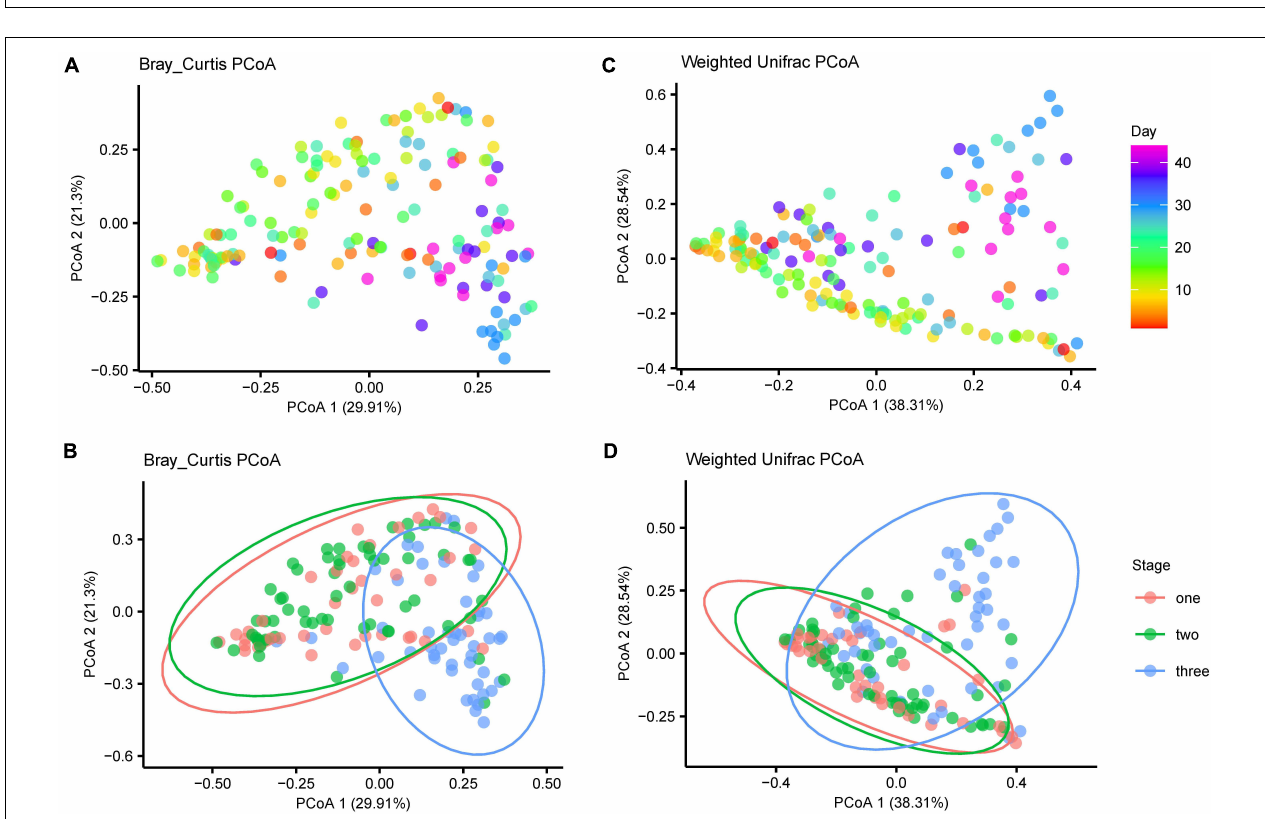
FIGURE 4 | (A) The alpha diversity (Shannon index) of gene function over time. The shadow around the lines reveals 95% CI. The alpha diversity was estimated using the Shannon index. (B) The beta (Bray-Curtis distance) diversity of gene function over time. The Bray-Curtis distance calculated at the KO level across microbiota from samples collected at the same time point. Higher values denoted more dissimilar gene function.